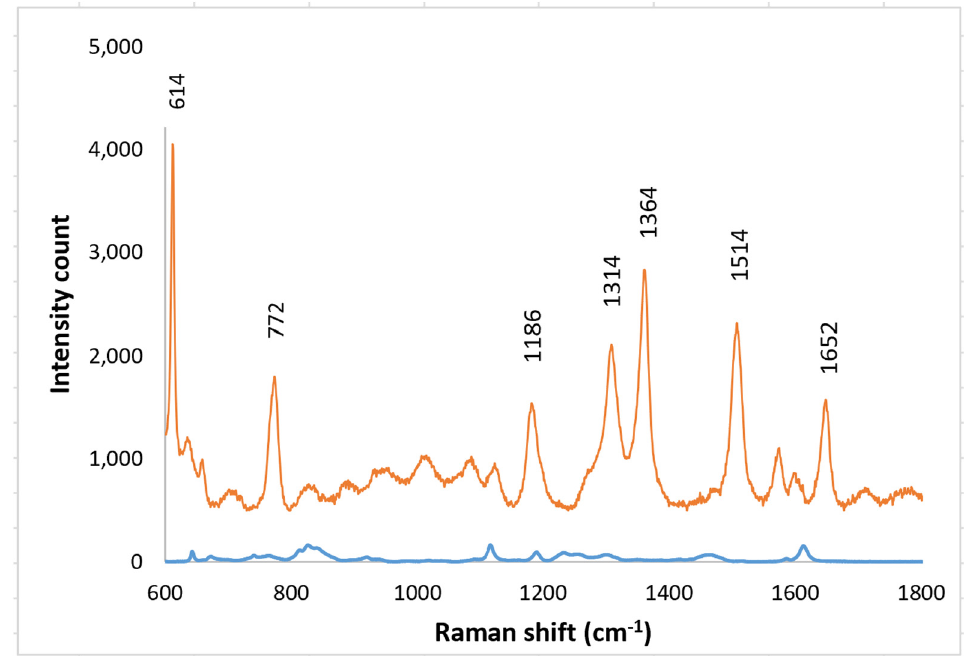
Figure 11. Top trace, Raman spectrum of 1 mm R6G obtained after transferring nanospheres to epoxy on glass. Bottom trace, Background spectra from the transferred nanospheres to epoxy on glass with no R6G present.